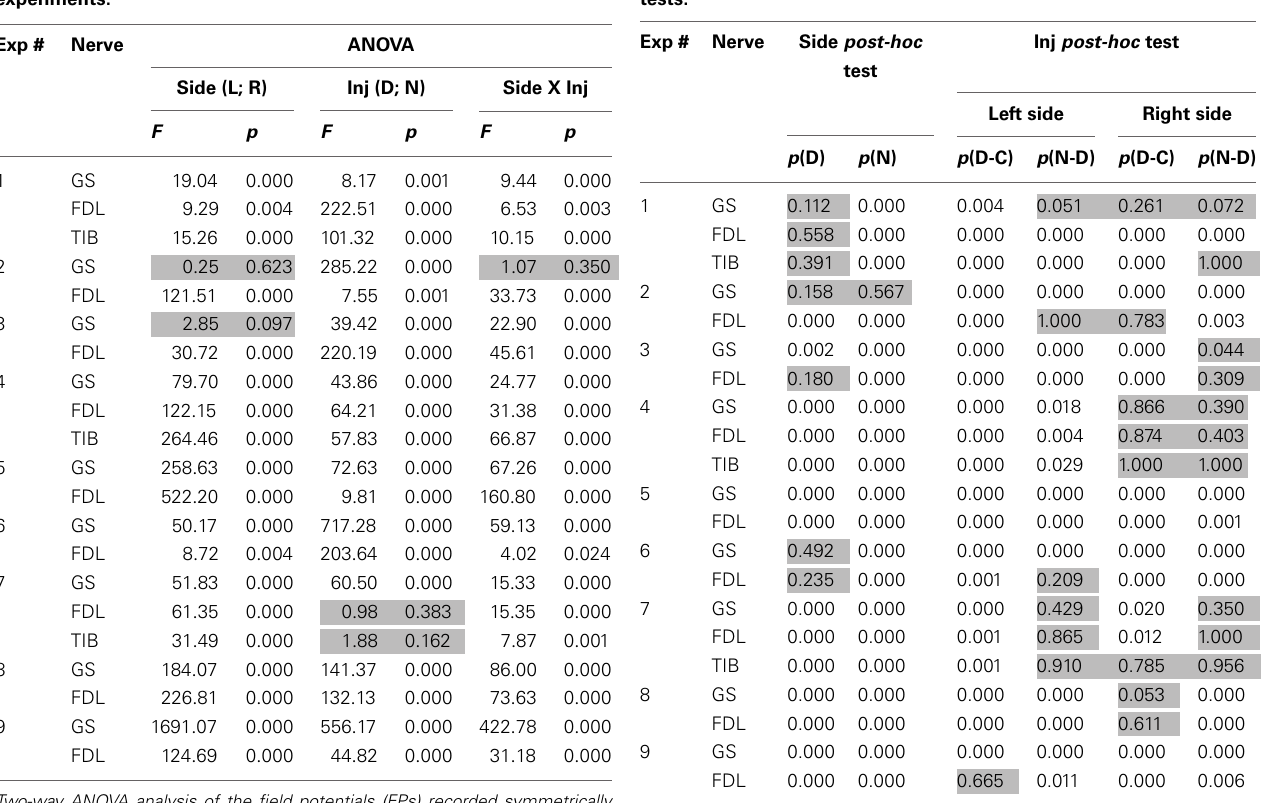
Table 2 | Post-hoc analysis of the data for continuation of the